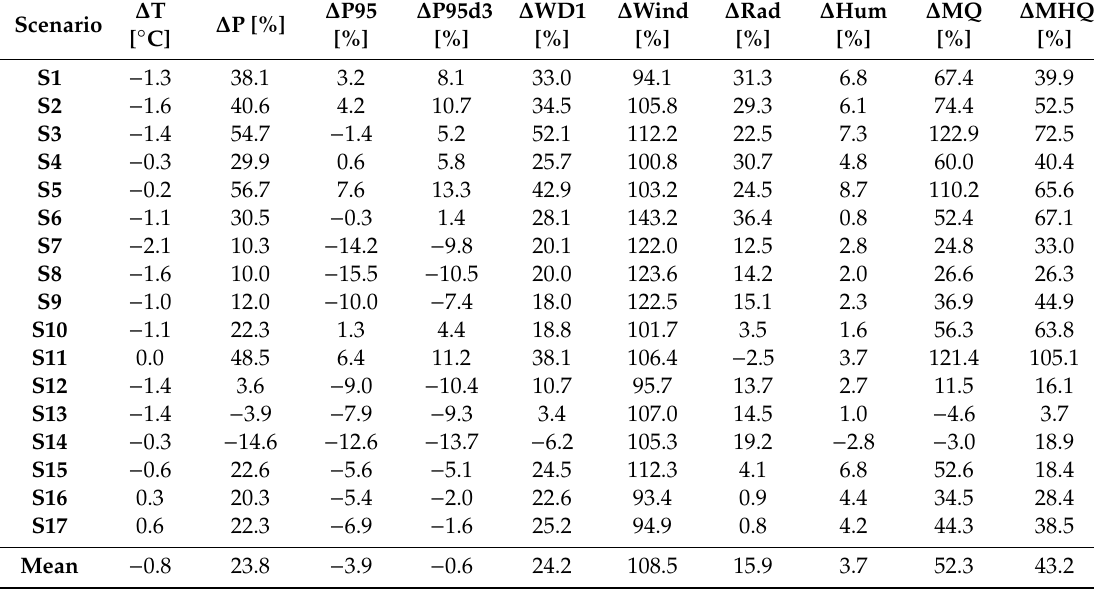
Table 2. Deviations of climate variables and simulated discharge parameters between climate scenario data and observational data for the period 1971–2000. Climate variables: temperature (T), precipitation (P), 95% percentile of precipitation / 3-day precipitation sum (P95 / P95d3), number of wet days > 1 mm (WD1), wind Speed (Wind), global radiation (Rad) and relative humidity (Hum); hydrological parameters: mean discharge (MQ) and mean annual peak flow